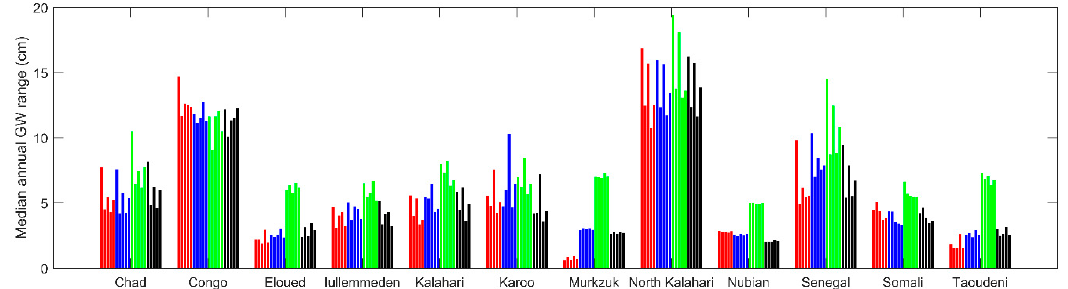
Figure 7. Comparison the difference between the maximum and minimum GWS change estimated for each aquifer basin, using the different GRACE products and LSM products.